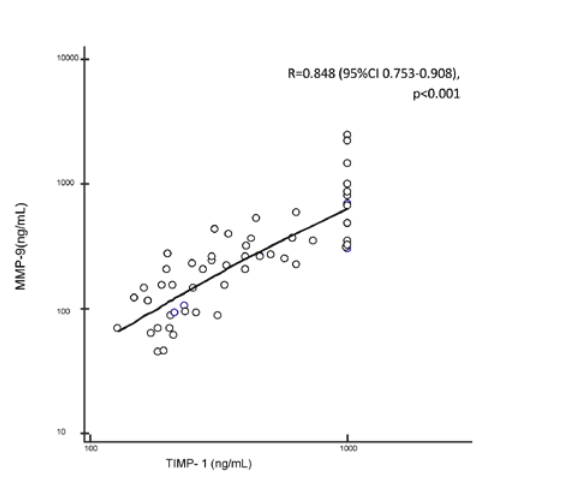
Figure 3: Serum MMP-9 (A) , TIMP-1 (B) and TIMP-1/MMP-9 (C) ratio in survivor and non-survivor patient (median; 25-75